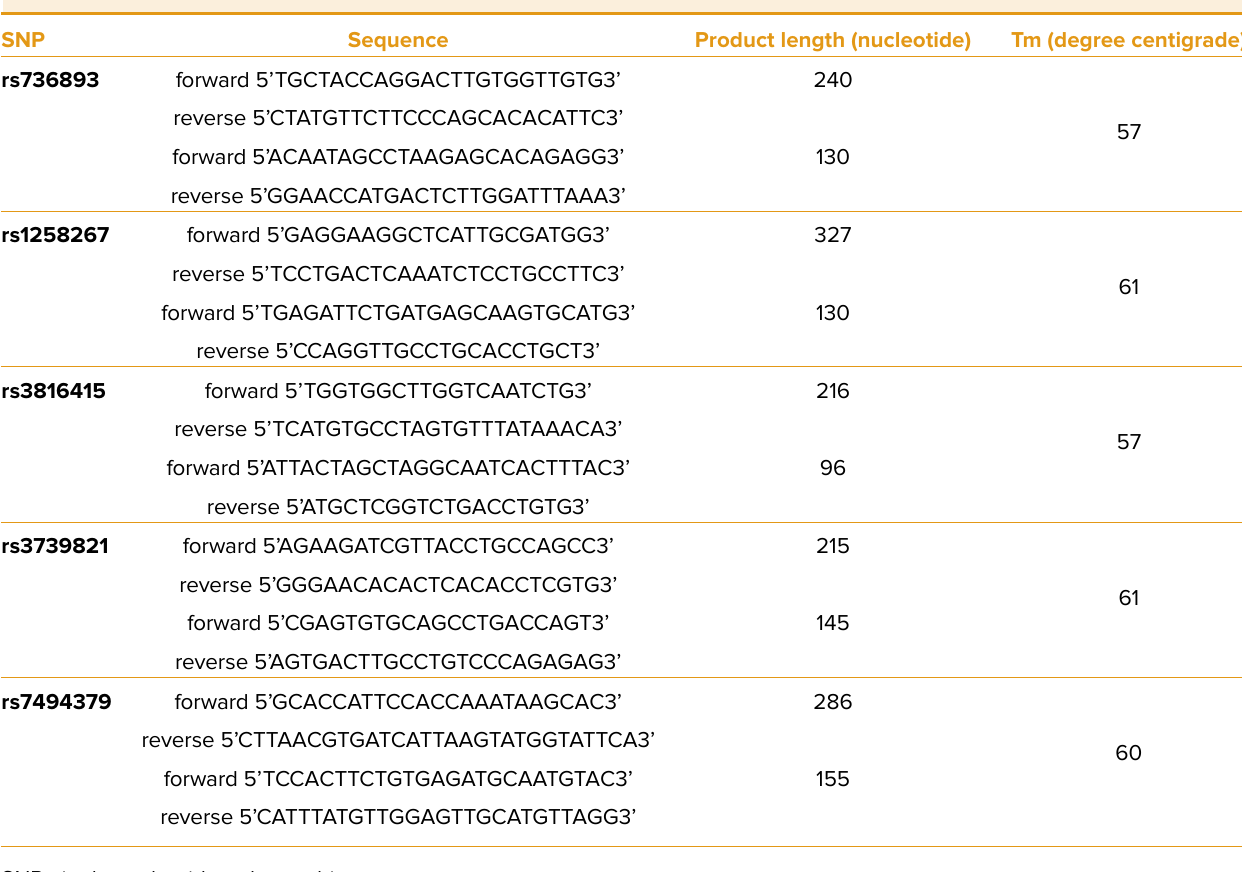
Table 1. Tetra-ARMS primer details.